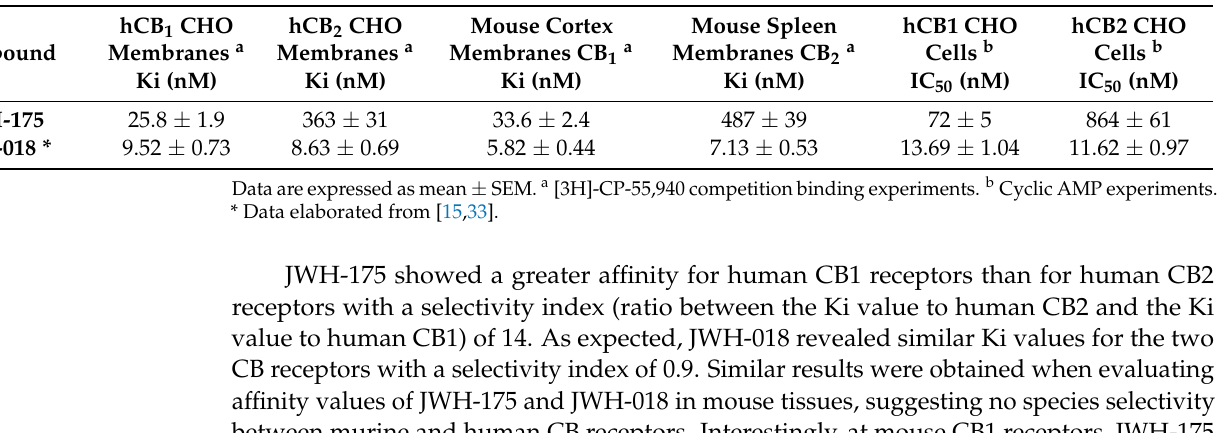
Table 1. Binding and functional parameters of JWH-175 at human and mouse CB1 and CB2 receptors, in comparison to